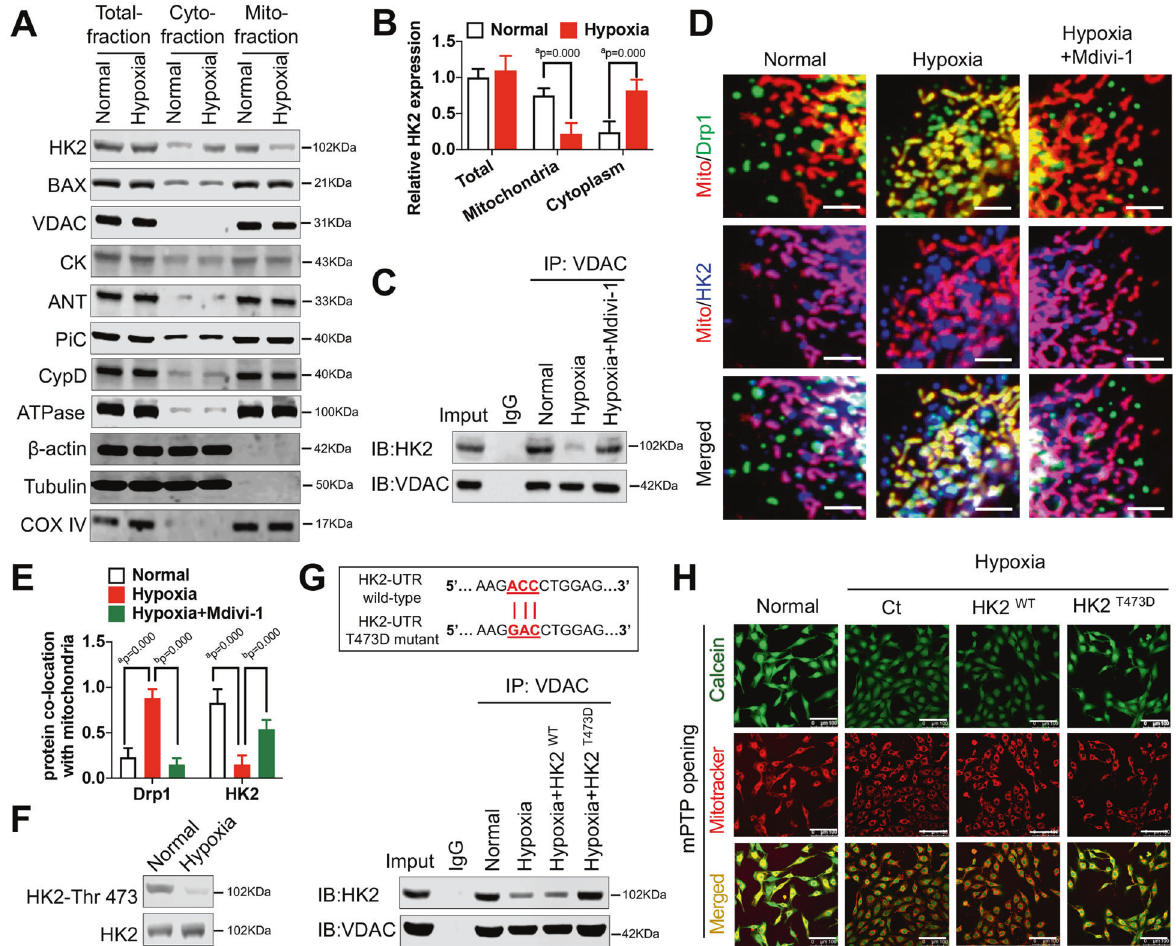
Fig. 3 Mitochondrial Drp1 leads to excessive mPTP opening through inducing HK2 mitochondrial separation after hypoxia. A and B The expression and statistical analysis of all mPTP related proteins in total, cytoplasmic and mitochondrial fractions of VSMCs after hypoxia. β -actin, Tubulin, and COX IV were used as interior references of total, cytoplasmic and mitochondrial fractions. ( n = 8 samples/group). C Co-IP results for the combination of HK2 and VDAC in hypoxia-induced VSMCs after Mdivi-1 (50 μ M) treatment. D and E Representative immuno fl uorescence images and statistics analysis showing the co-location of Drp1 (green), HK2 (blue), and mitochondria (red) in hypoxia- induced VSMCs after Mdivi-1 (50 μ M) treatment. (bar, 5 μ m). F Western blot analysis showing the phosphorylation of HK2-Thr 473 in VSMCs after hypoxia. G Co-IP results for the combination of HK2 and VDAC in hypoxia-induced VSMCs after HK2 T473D mutation. H Representative confocal images of mPTP opening in hypoxia-induced VSMCs after HK2 T473D mutation. (bar, 100 μ m). a: P < 0.05 compared with Normal group, b: P < 0.05 compared with Hypoxia